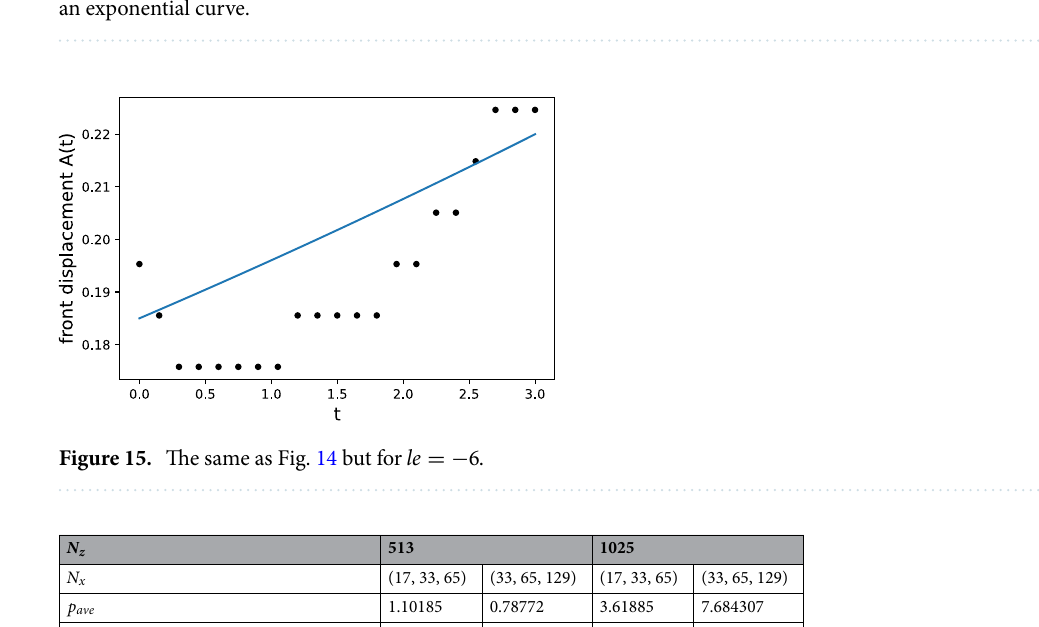
4 with a 65 1025 grid and the numerical growth rate is estimated by = − ×